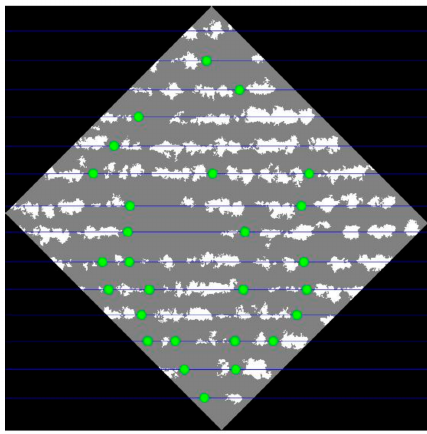
Figure 9. Relative locations (green dots) of the successive failures in Test_1 (Blue lines: centerlines of seedling